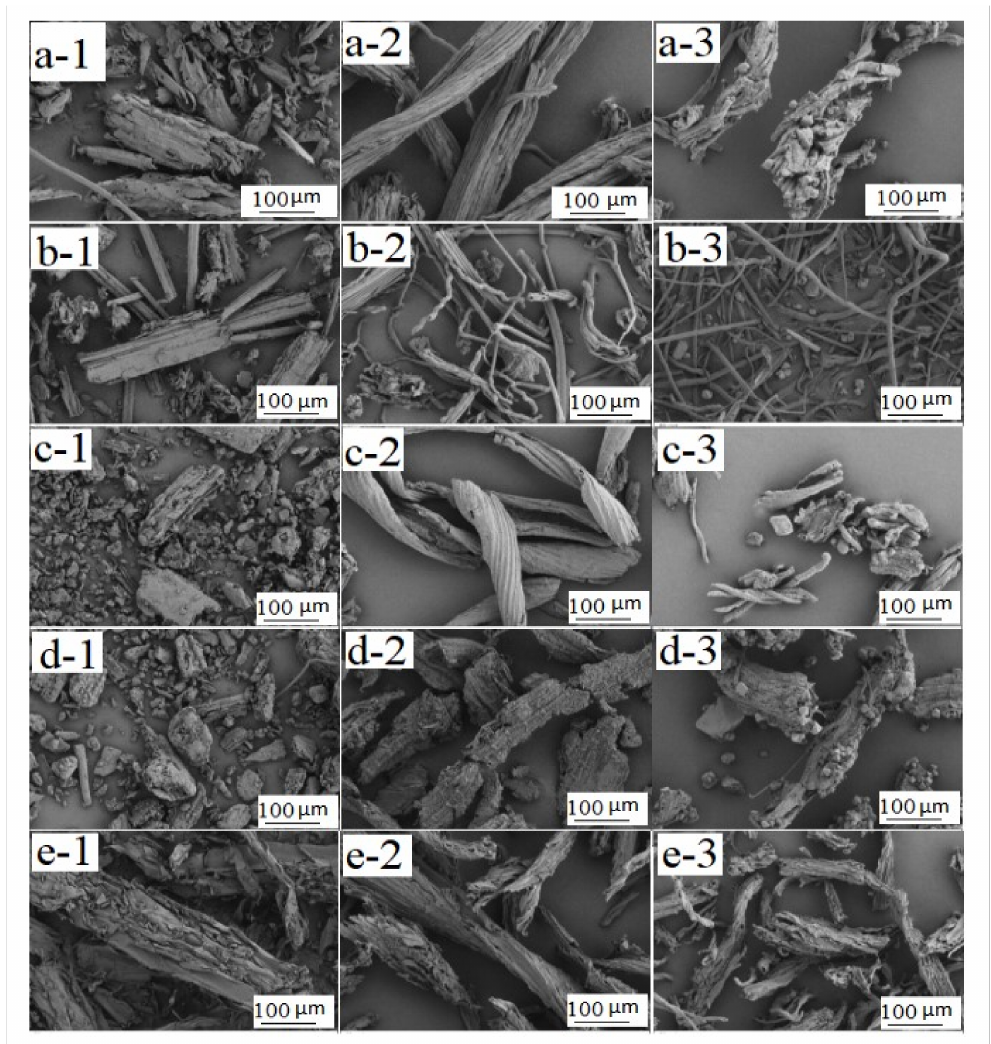
Figure 3. SEM images showing microstructure differences for the ( 1 ) the raw material, ( 2 ) the extracted cellulose, and ( 3 ) the resulting CMC derived from ( a ) pine wood, ( b ) bamboo culm, ( c ) pine needles, ( d ) bamboo leaves, and ( e ) hemp